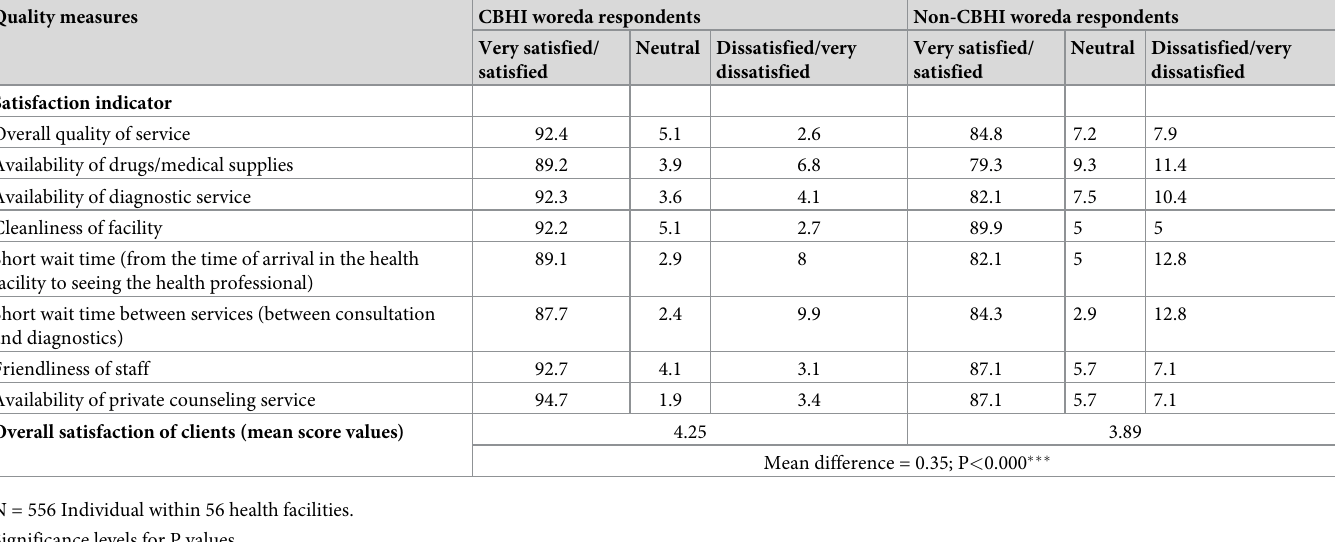
Table 3. Patient satisfaction with service received